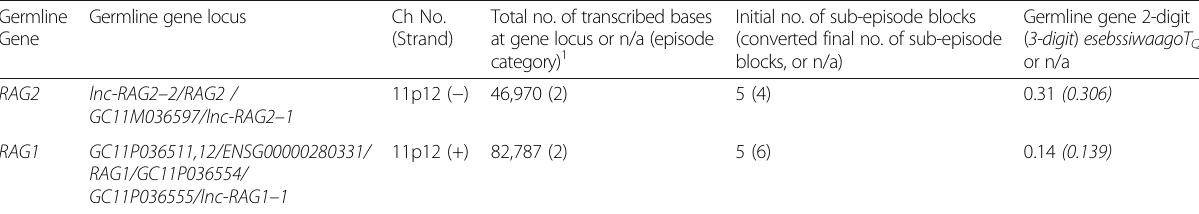
Germline gene 2-digit ( 3-digit ) esebssiwaagoT Q , or n/a